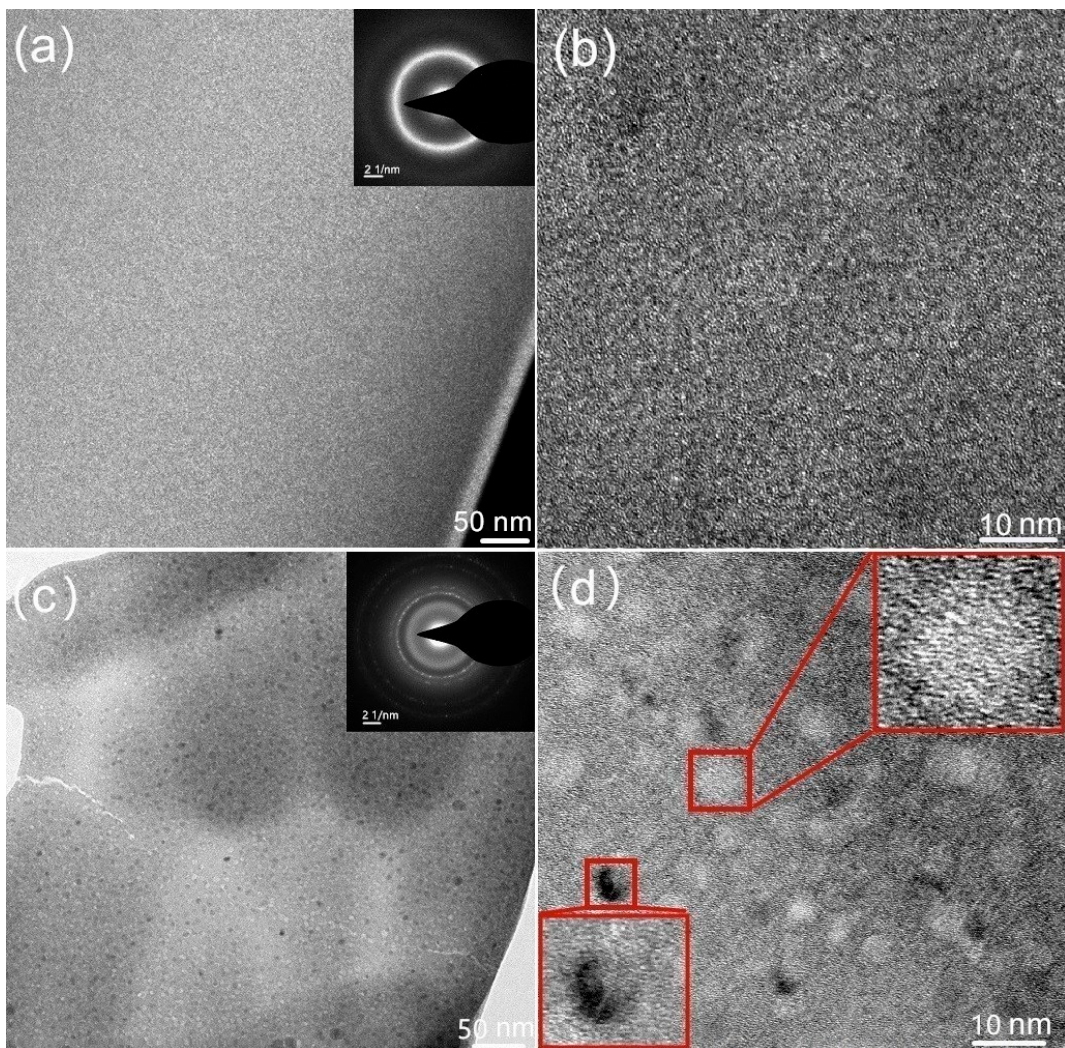
Figure 4. ( a ) Bright-field TEM micrograph and the selected-area electron di ff raction patterns of the as-cast Zr 52 Cu 42.5 Al 5.5 alloy; ( b ) HRTEM micrograph for the as-cast Zr 52 Cu 42.5 Al 5.5 alloy; ( c ) Bright-field TEM micrograph and the selected-area electron di ff raction patterns of the as-cast Zr 52 Cu 42 Al 5.5 Nb 0.5 alloy and ( d ) HRTEM micrograph for the as-cast Zr 52 Cu 42 Al 5.5 Nb 0.5